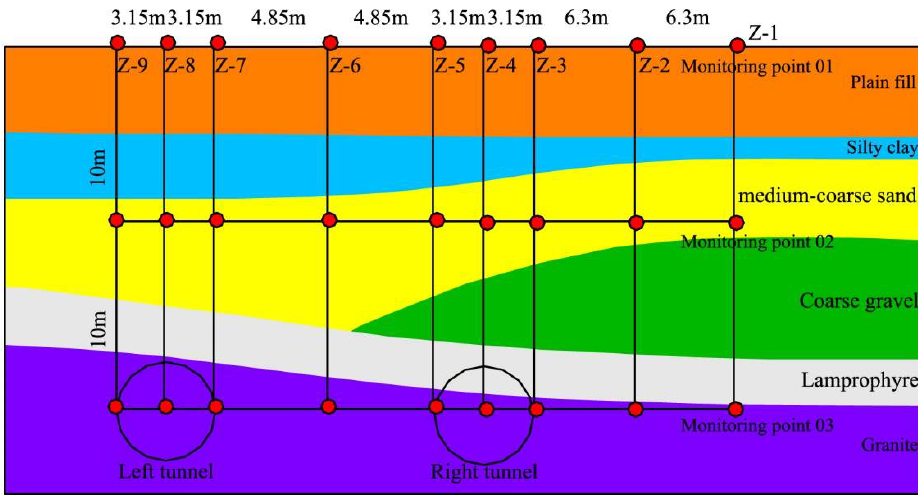
Figure 5. Measuring point layout of vibration monitoring.